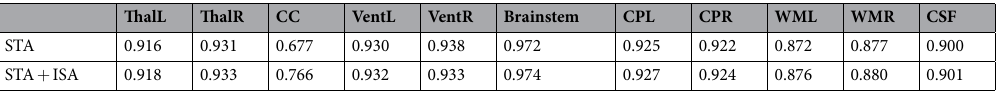
Table 1. Comparing average DSC metrics for multi-atlas segmentation using the spatiotemporal atlases (STA) and the combination of STA and individual subject atlases (STA + ISA). ThalL: left thalamus, ThalR: right thalamus, CC: corpus callosum, VentL: left lateral ventricle, VentR: right lateral ventricle, Brainstem: brainstem, CPL: left cortical plate, CPR: right cortical plate, WML: left white matter, WMR: right white matter, and CSF: cerebrospinal fluid. In average higher DSC values were obtained from STA + ISA, which was expected due to the use of larger number of atlases. The difference was particularly high for